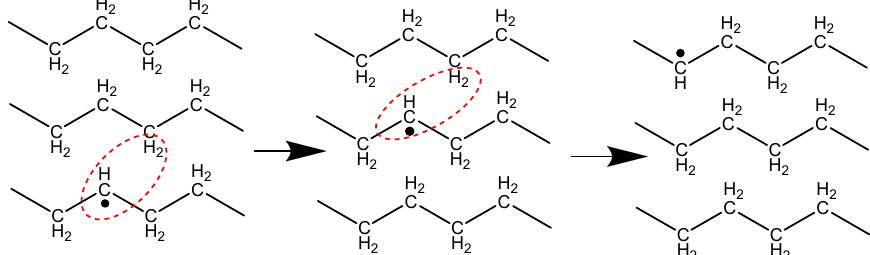
Figure 2. Hydrogen abstraction from one chain to another, and the simultaneous hop of the radical site. Reproduced from [19], with the permission of AIP Publishing. Copyright AIP Publishing, 1987.